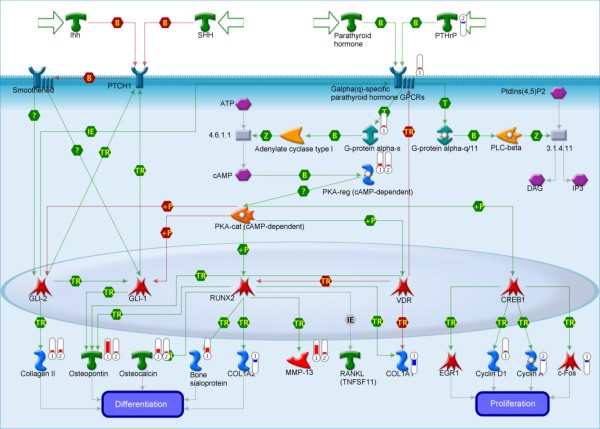
Hedgehog and Parathyroid Hormone Signaling Pathways in Bone and Cartilage Development. Red symbols indicate degree of up-regulation of gene target in DFI < 100 days relative to DFI > 300 days, blue symbols indicate relative down-regulation. Numbers in symbols indicate specific array processing algorithm, 1 = PLIER, 2 = RMA.